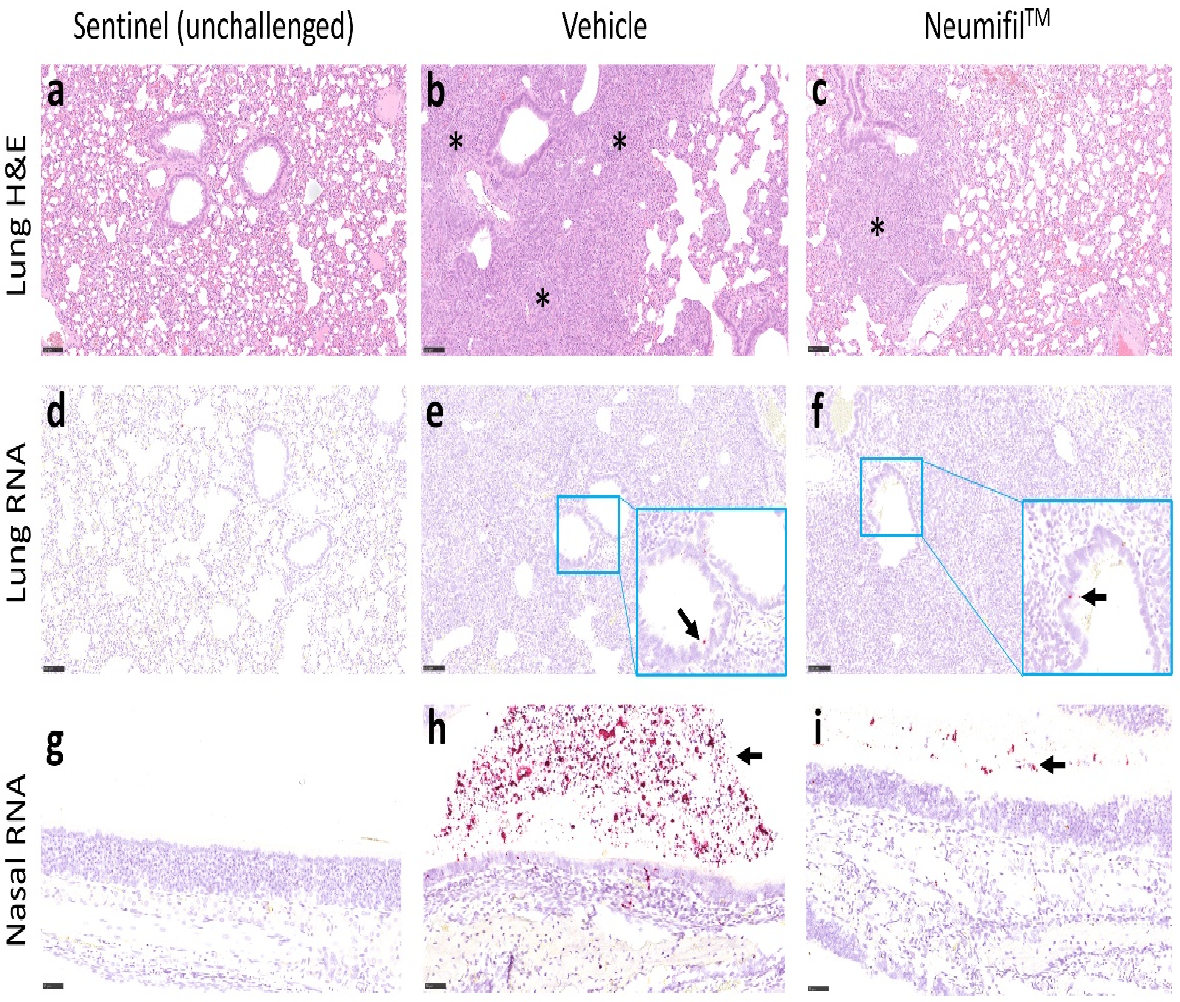
Figure 5. Representative images of lung histopathology (H&E) and presence of viral RNA (in situ hybridisation) in respiratory samples. ( a – c ) Lung histolopathology. Areas of bronchopneumonia (*) were observed in the lungs from both vehicle-treated and Neumifil-treated animals, with a lower severity in the Neumifil-treated group. ( d – f ) Presence of viral RNA in the lung. A small amount of virus RNA was detected in the airway epithelium and inflammatory infiltrates within the lung and olfactory/respiratory epithelium (arrows). ( g – i ) Presence of viral RNA in the nasal cavity. Inflammatory infiltrates and exudates were detected within the nasal cavity (arrows). Scale bars on lung images represent 100 µ m and on nasal cavity images represent 50 µ